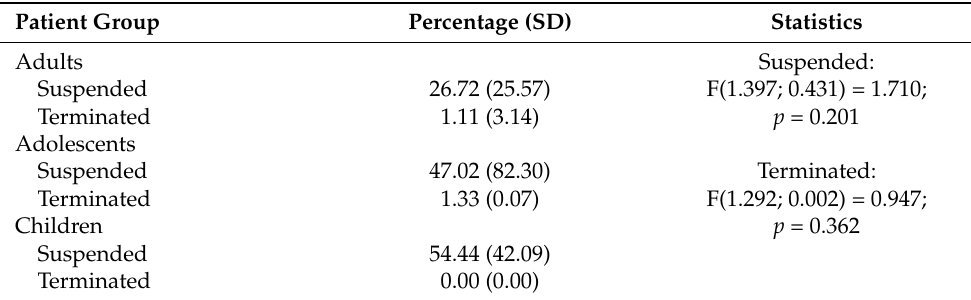
Table 4. The proportion of treatments suspended and terminated since the COVID-19 lockdown by patient group.